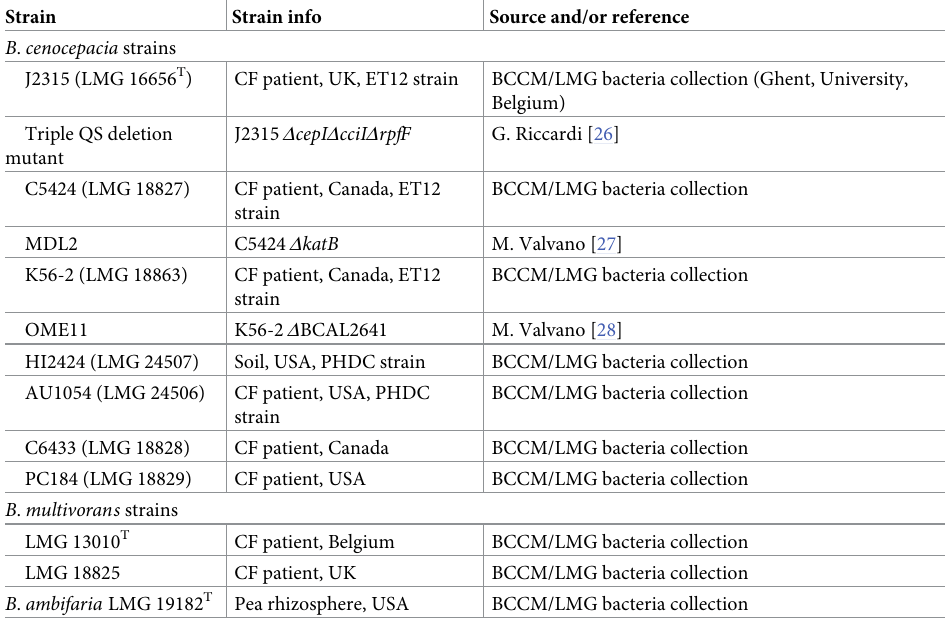
Table 1. Strains used in the present